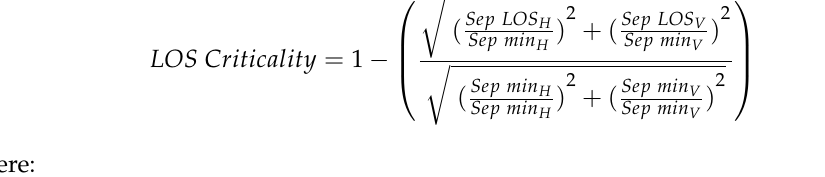
Figure 5. Risk array for LOS criticality.